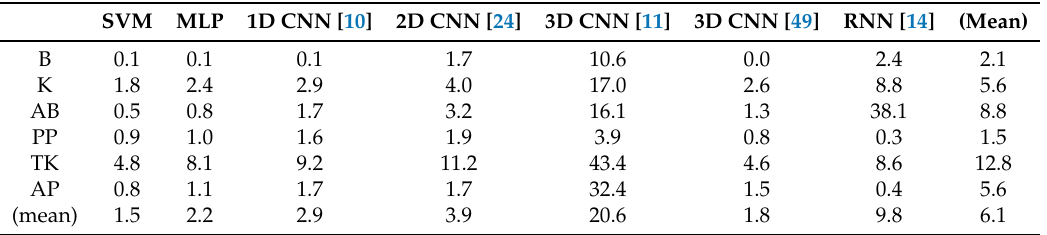
Table 5. Per-class percentage of errors for each method, aggregated over inductive experiments with F/frame images (second part of the HIC experiment, F(2) ↔ F(2k) ).